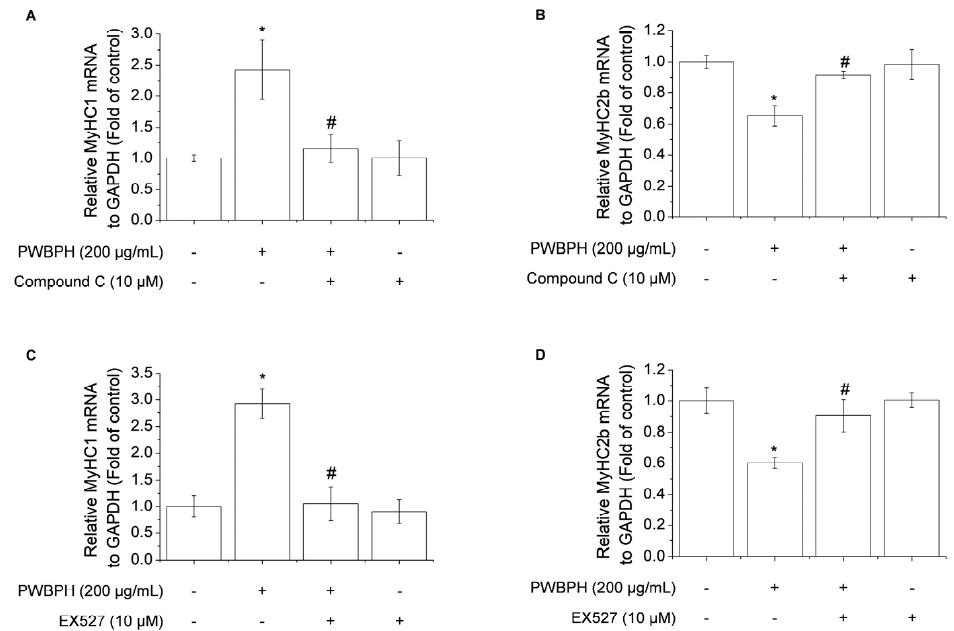
Figure 7. Role of AMPK and SIRT1 in PWBPH-mediated muscle fiber conversion in C2C12 myotubes. About 90% confluent C2C12 cells cultured in differentiation medium for 4 days and then cells were pretreated with the ( A , B ) AMPK inhibitor compound C (10 µ M) or ( C , D ) SIRT1 inhibitor EX527 (10 µ M) for 1 h before being treated with PWBPH (200 µ g/mL) for 3 days. qRT-PCR analysis of the mRNA levels of MyHC1 and MyHC2b . Data are the means ± standard deviation ( n = 3). * p < 0.05 vs. control group. # p < 0.05 vs. PWBPH-treated group.